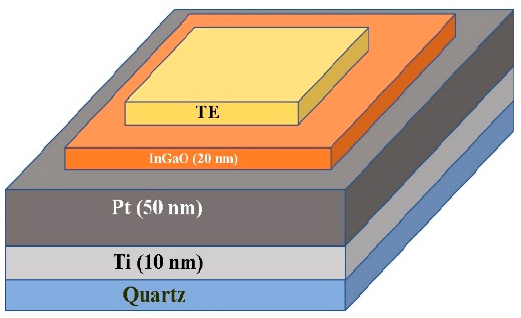
Figure 1. Schematic of the InGaO RRAM structure.